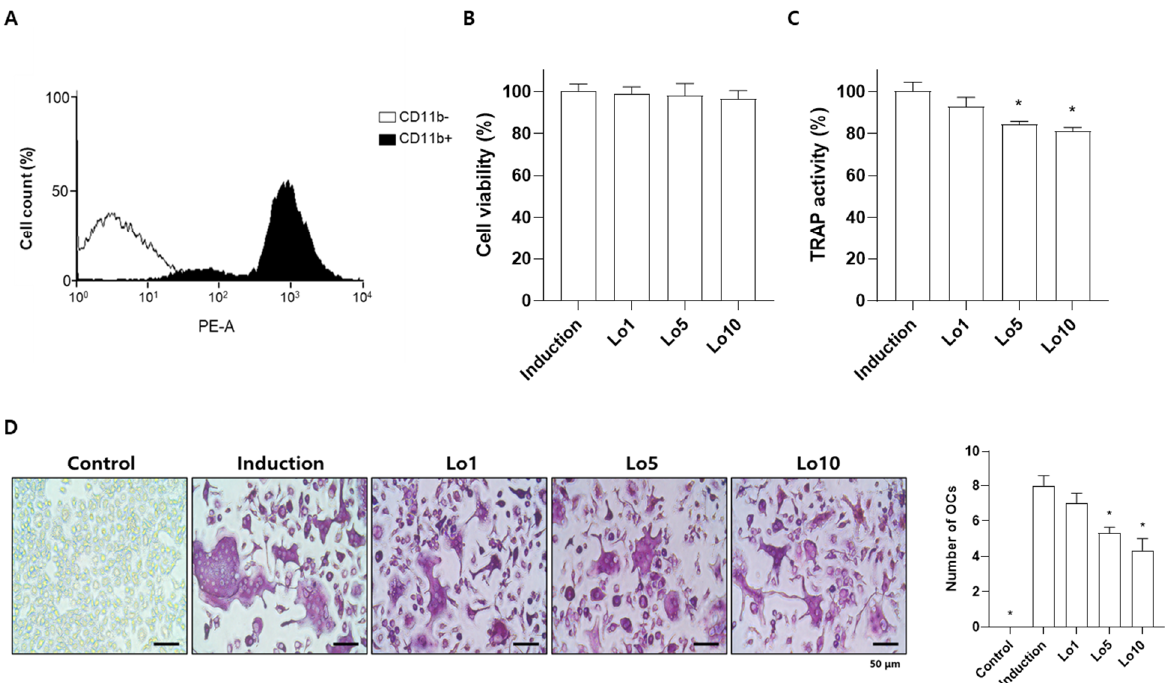
Figure 3. Effects of loganin on the differentiation of mouse bone marrow monocytes into osteoclasts. Bone marrow monocytes were incubated in osteoclast induction medium (50 µ g/mL of macrophage/monocyte stimulating factor (M-CSF) and 50 µ g/mL of receptor activator of nuclear factor κ B ligand (RANKL)) with different concentrations of loganin (1, 5, and 10 µ M) for 5 days.